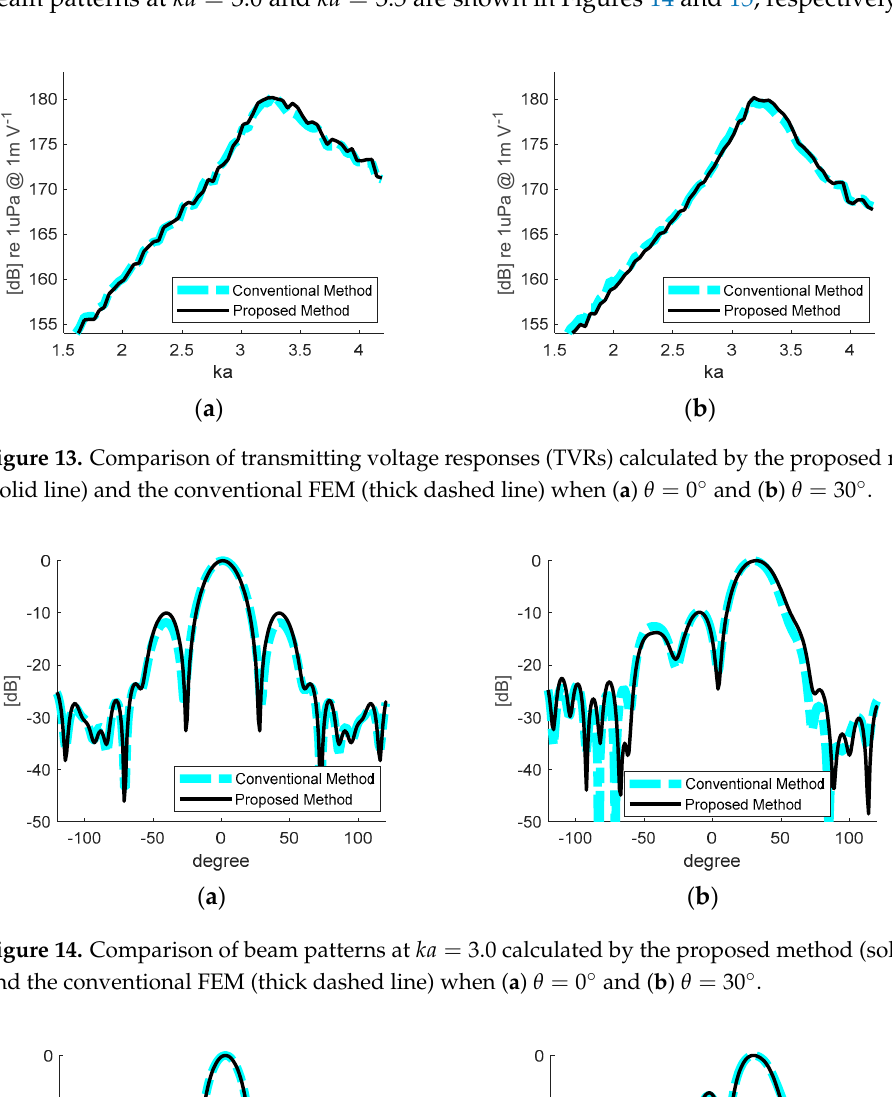
Figure 14. Comparison of beam patterns at ka = 3.0 calculated by the proposed method (solid line) and the conventional FEM (thick dashed line) when ( a ) θ = 0 ◦ and ( b ) θ = 30 ◦ .